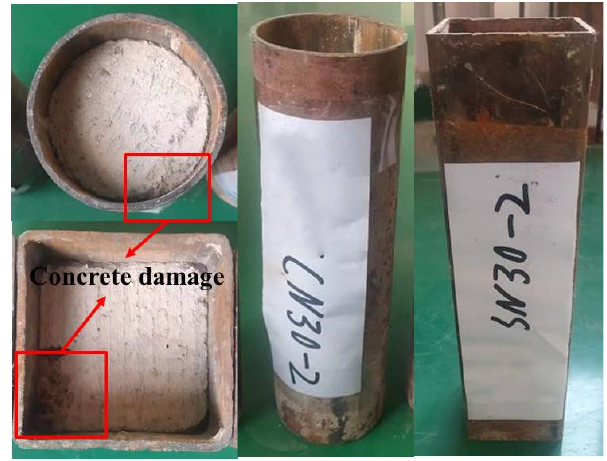
Figure 7. Failure mode of push-out specimens.